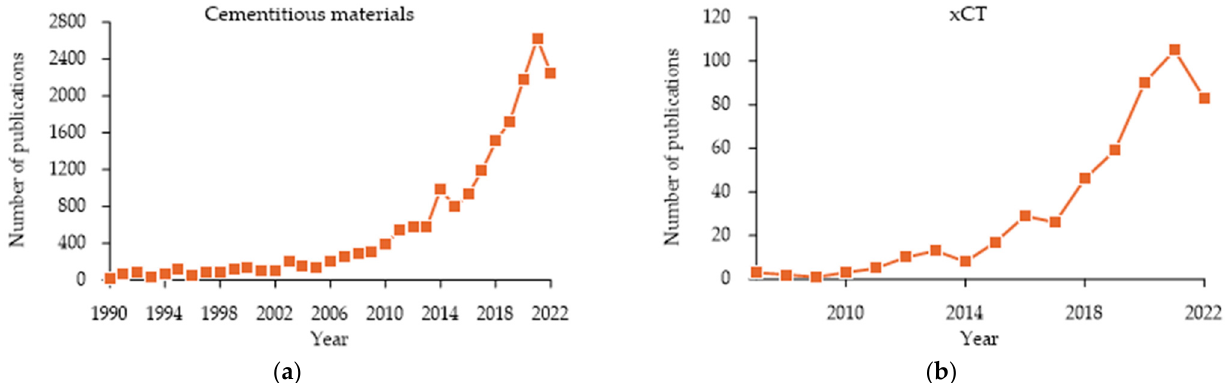
Figure 1. Graphs of published papers over time based on the Web of Science catalog ( a ) cementitious materials; ( b ) xCT (X-ray computed tomography) in the categories materials science multidiscipli-